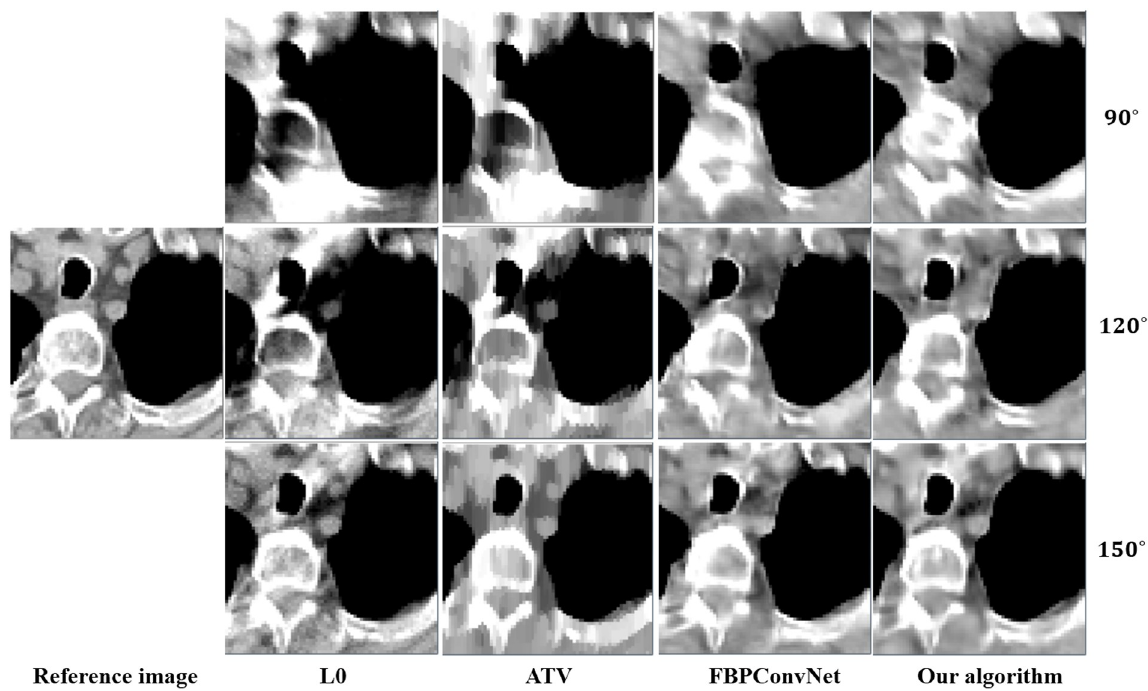
Fig 13. The zoom-in view of the ROIs for the Fig 11. The image on the first column is ROI of the reference image. The subsequent columns are the ROIs of the reconstructed image for L0 method, ATV method, FBPConvNet method and our algorithm.